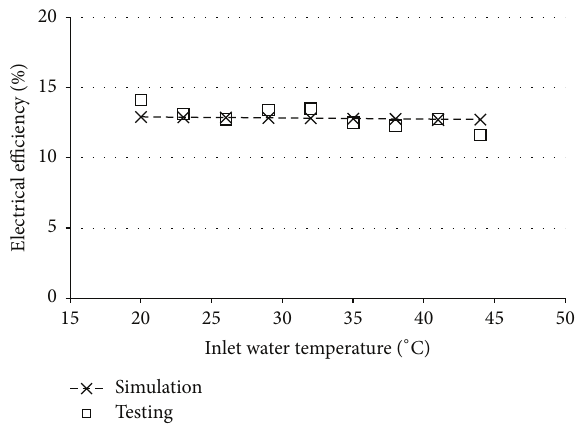
Figure 9: Variation of electrical efficiency with solar radiation.